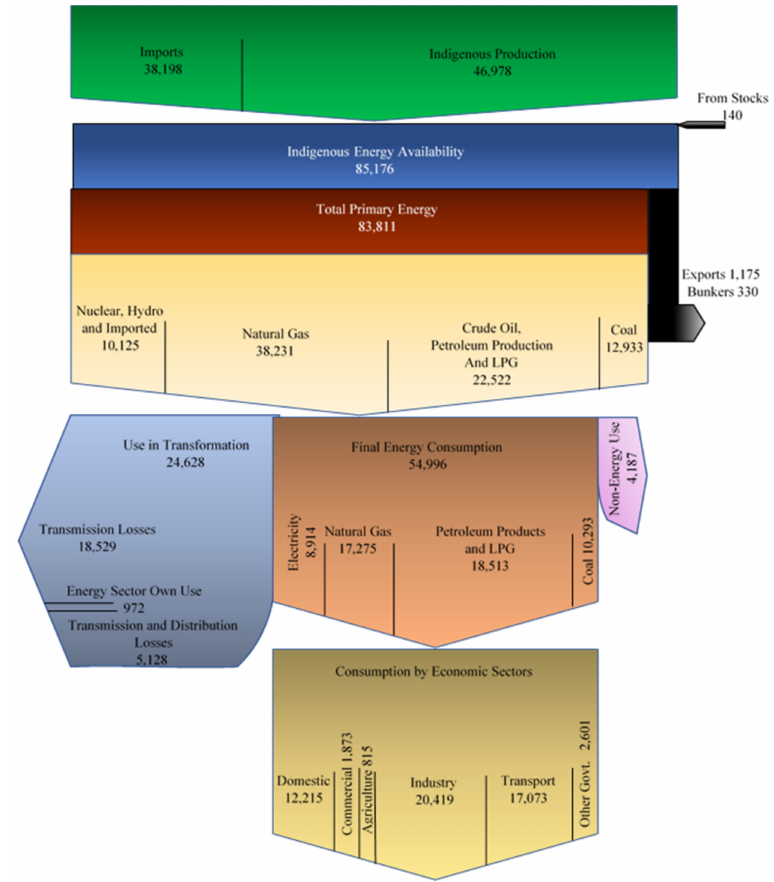
Figure 3. Flow chart of Pakistan’s energy system